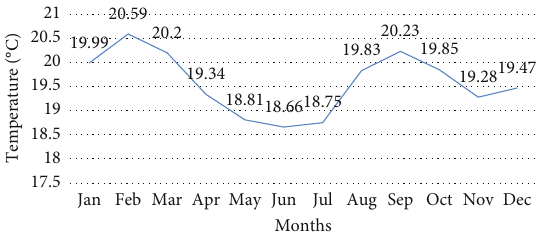
Figure 49: Monthly temperature variation ( ° C) for